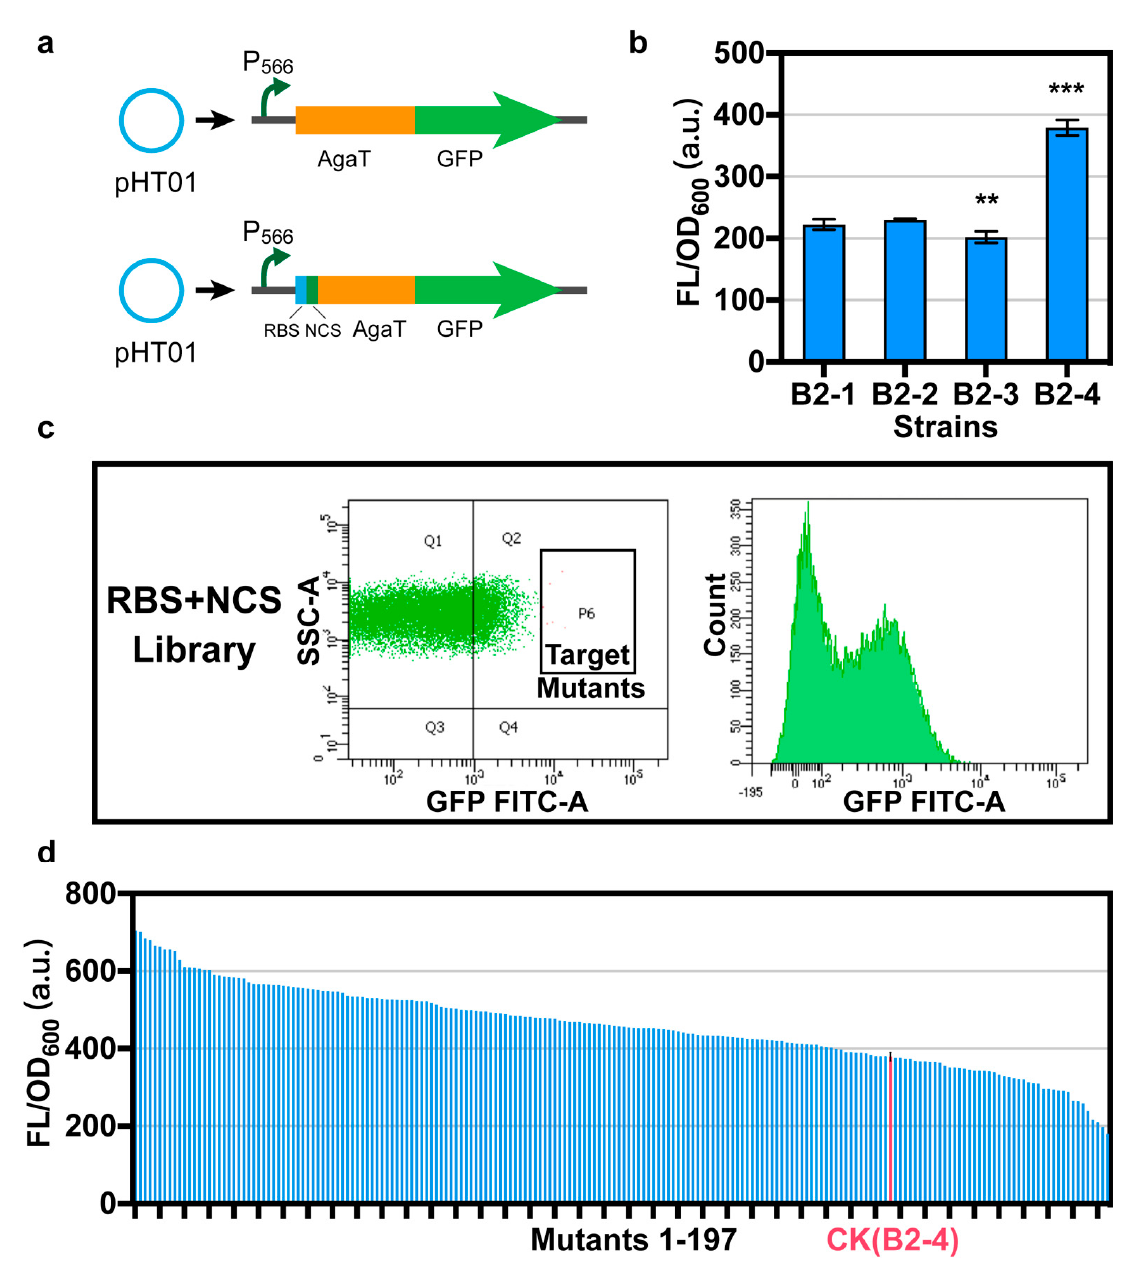
Figure 2. Optimizing RBS and NCS of agaT . ( a ) In order to optimize the RBS and NCS of agaT , we attached a gfp after agaT through a linker. Please refer to Table 3 for the starting sequence of RBS and NCS. ( b ) The relative fluorescence intensity of strains B2-1, B2-2, B2-3, and B2-4 under the control of different promoters. ( c ) Screening of the random mutant library for efficient mutant using flow cytometry. SSC-A: granularity, FITC-A: GFP fluorescence. ( d ) Characterization of 197 strains obtained from the library. We detected the relative fluorescence intensity of the 197 strains. Data are shown as mean ± S.D. from three ( n = 3) biological replicate experiments, and significance determined from Student’s t -test, where ** p < 0.005, *** p < 0.0005, and N.S. = not